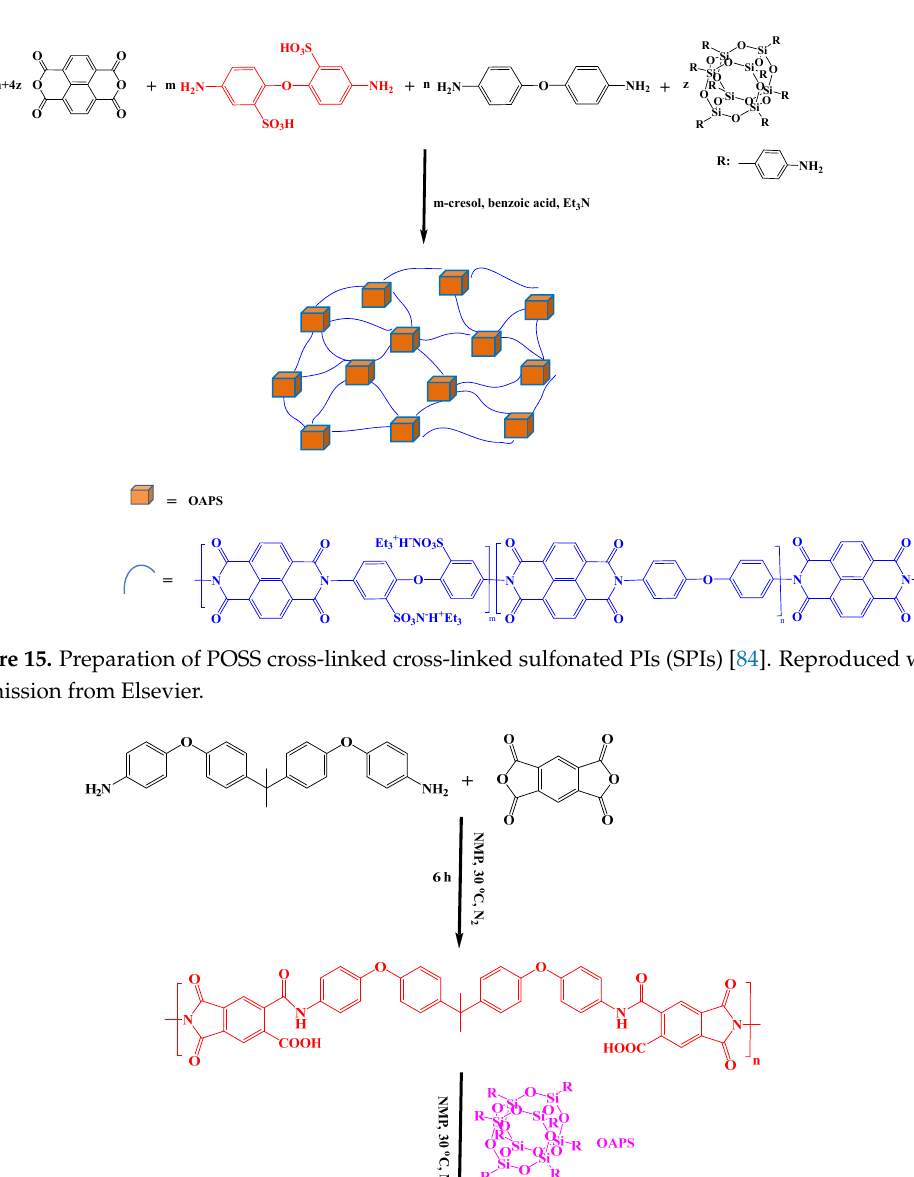
10 Figure 14. Preparation of OG-POSS cross-linked PIs [83]. Reproduced with permission from Elsevier.